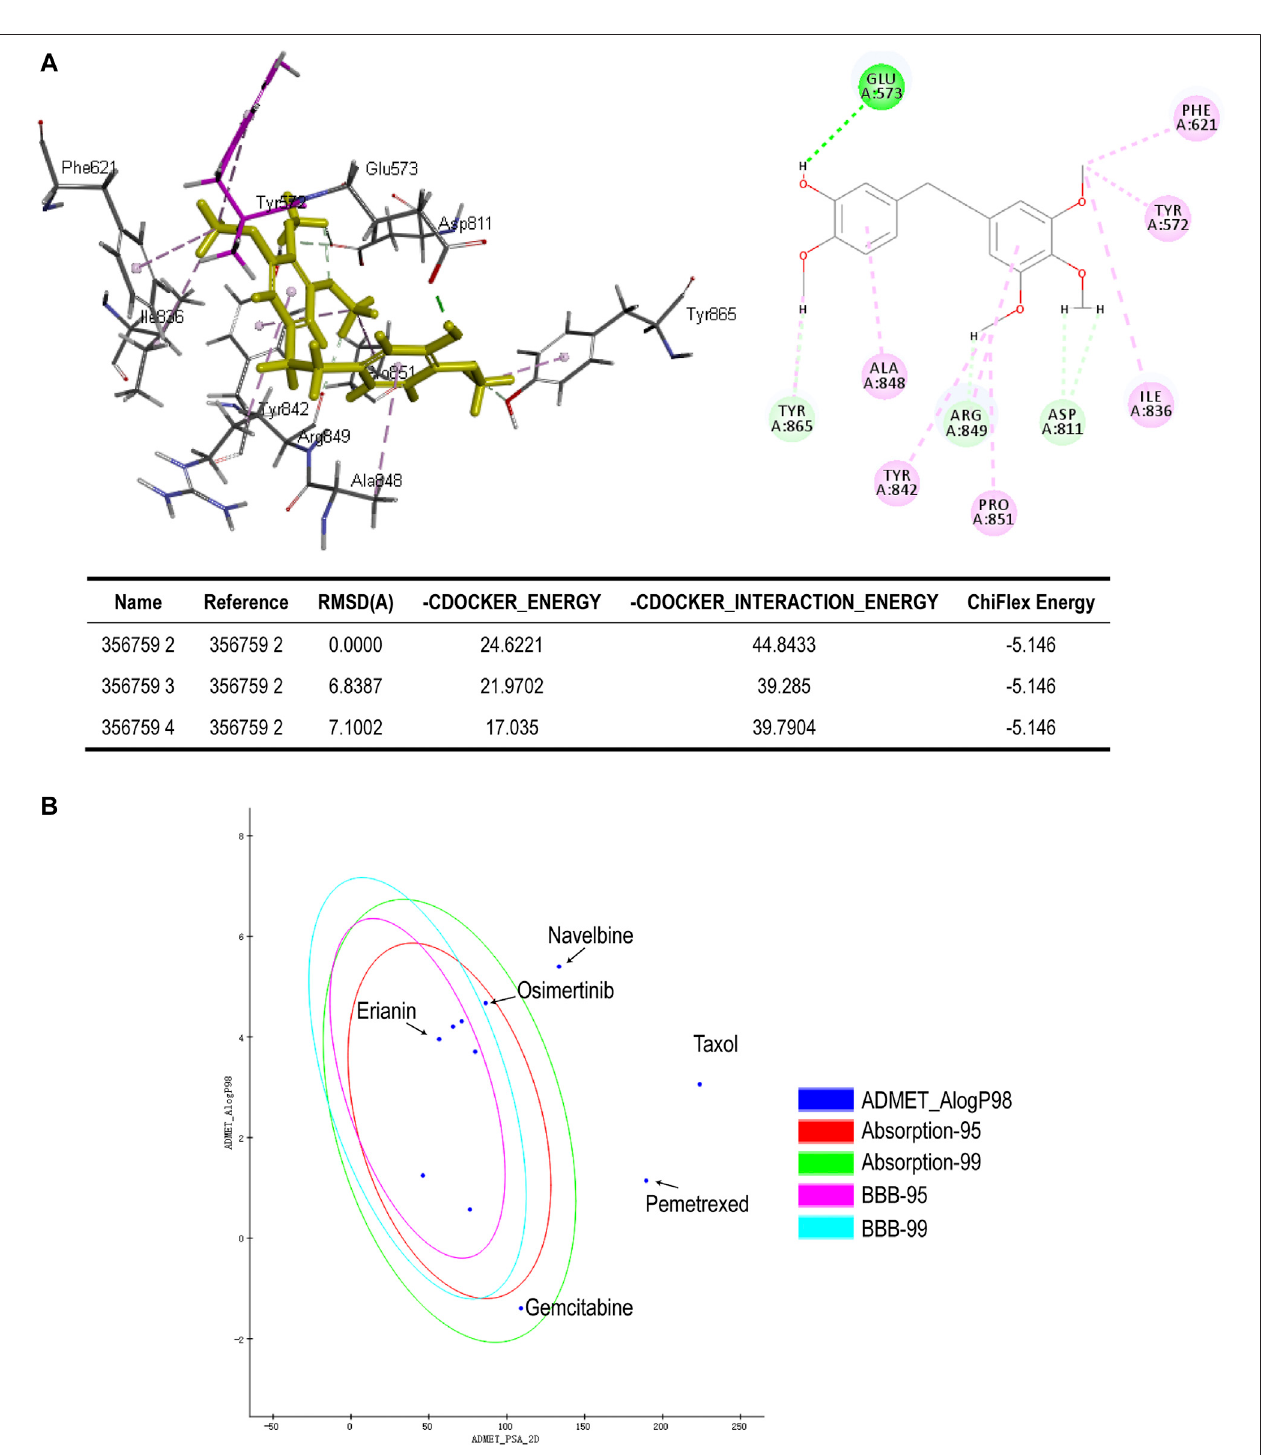
FIGURE 6 |(A) Binding oferianin with FLT3 by molecular docking. Erianin exhibits high binding af fi nity to FLT3 protein via sites of Glu573, Phe621, Tyr572, Ile836, Asp811, Pro851, Arg849, Tyr842, Ala848, and Tyr865. (B) ADMET plot, plotted by ADMET_PSA_2D vs. ADMET_AlogP98. The dark blue dots represent AlogP98 of eachdrug.Theredandgreenellipsesrepresent95and99%con fi denceintervalsoftheblood – brainbarrier(BBB)permeabilitymodel,respectively,andtheroseredand light blue ellipses represent 95 and 99% con fi dence intervals of the human intestinal absorption (HIA) model, respectively.